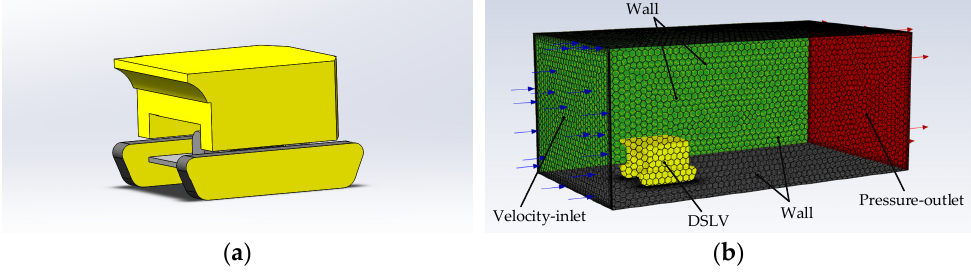
Figure 7. Pretreatment of computational fluid dynamics (CFD): ( a ) full-scale simplified model; ( b ) computational domain.